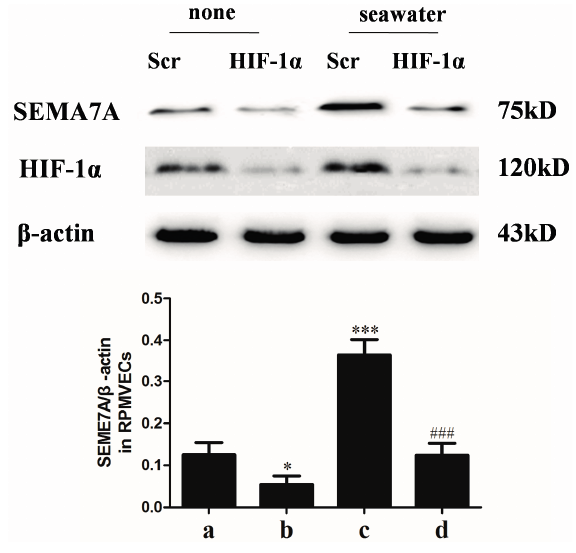
Figure 5. Hypoxia-inducible factor (HIF)-1 α in endothelial SEMA7A induction in RPMVECs stimulated by seawater. All data were obtained at 6 h after seawater administration. (a) Negative scrambled control (Scr siRNA) group; (b) HIF-1 α siRNA group; (c) seawater + negative scrambled control (Scr siRNA) group; (d) seawater + HIF-1 α siRNA group. n = 8, * p < 0.05, *** p < 0.001 versus group a, ### p < 0.001 versus group